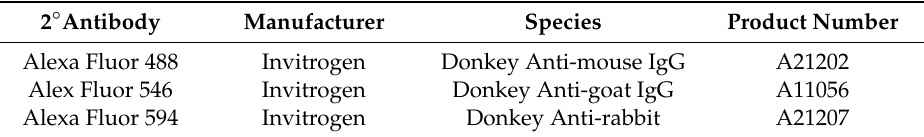
Table 3. Secondary antibodies utilized for